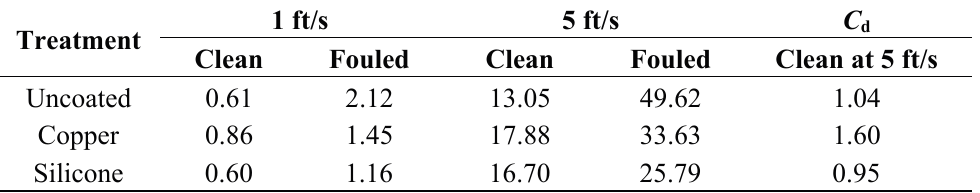
Table 3. Average drag forces measured on the nets in the clean and fouled condition and the calculated drag coefficient at 5 ft/s (1.5 m/s) for the clean